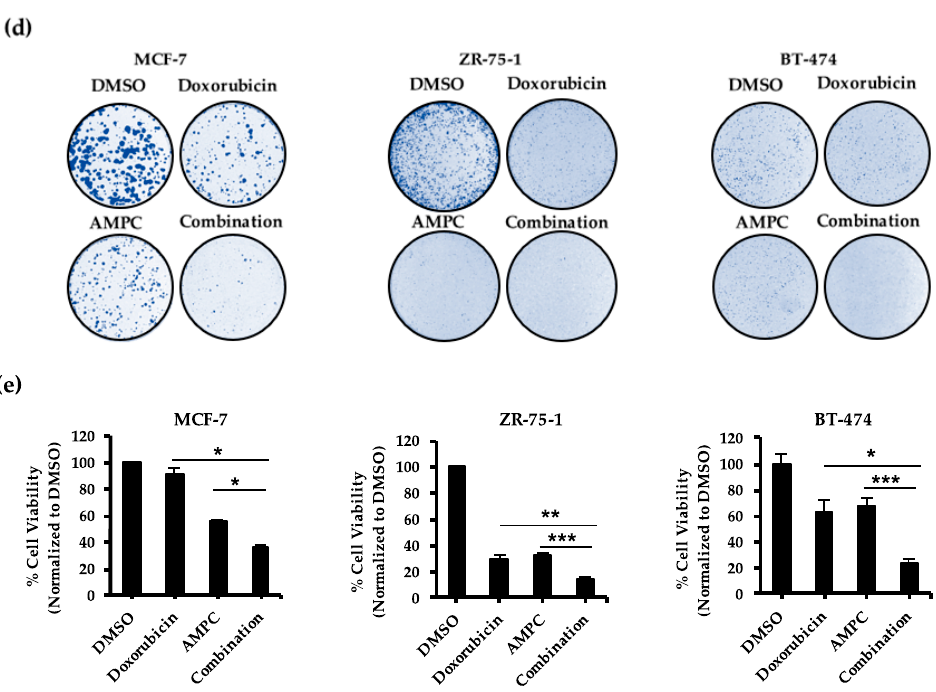
Figure 1. Inhibition of TFF3 enhances cellular sensitivity to doxorubicin. (a–b). MCF-7, ZR-75-1 and BT-474 cells (a) pre-incubated with 20nM of two TFF3 siRNA combined overnight or (b) treated with 10µM AMPC were treated with increasing doses of doxorubicin for 72 h in monolayer culture. Cell viability was quantified using the AlamarBlue cell viability assay where the 50% inhibitory concentration (IC 50 ) values for doxorubicin were determined using GraphPad Prism 5. Western blot analysis determined the protein expression of TFF3. β -ACTIN was used as input control. Band intensities were quantified by ImageJ and normalized to input control, where intensity ratio of scrambled siRNA/vehicle DMSO treatment was set to 1. ( c–e). MCF-7, ZR-75-1 and BT-474 cells were treated with doxorubicin with or without AMPC (c) over a period of 6 days in monolayer culture (MCF-7: 50 nM dox, 1 µM AMPC; ZR-75-1: 200 nM dox, 5 µM AMPC; BT-474: 100 nM dox, 5 µM AMPC); (d) in monolayer culture at low cell density until foci formation (MCF-7: 50 nM dox, 1 µM AMPC; ZR-75-1: 25 nM dox, 2 µM AMPC; BT-474: 10 nM dox, 1 µM AMPC); and (e) for 9 days after 5 days pre-culture in medium containing 5% FBS and 4% Matrigel (MCF-7: 50 nM dox, 2 µM AMPC; ZR-75-1: 200 nM dox, 5 µM AMPC; BT-474: 50 nM dox, 5µM AMPC). Cell viability was quantified using the AlamarBlue cell viability assay. Bar charts show means ± standard deviations. * denotes doxorubicin vs combination treatment; ◆ denotes AMPC vs combination treatment where * P < 0.05, ** P < 0.01 and *** P < 0.001 (Student’s t -test).